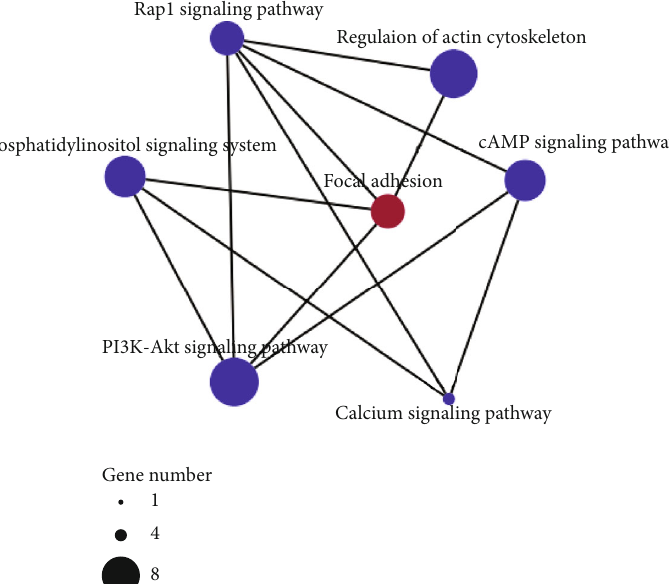
Figure 8: Network map of metabolic pathways associated with the focal adhesion pathway. The KEGG-based metabolic pathway network map of enriched upregulated genes in 36 hpi-vs-Con. The node sizes represent the numbers of enriched upregulated